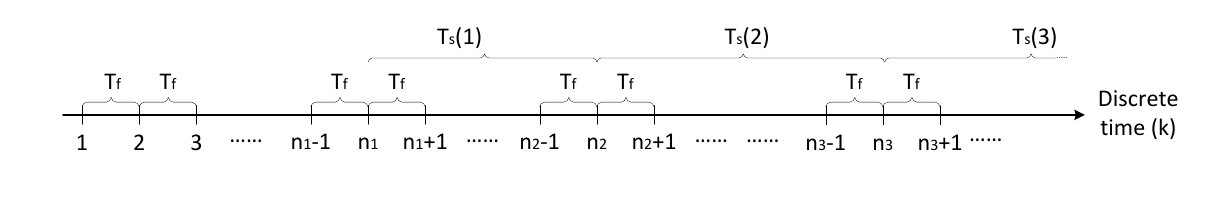
Figure 5: Time line showing the fast sampling rate T f used for the input variables, and the slow sampling rate T s ( i ) used for the output measurement (the aluminium height). As indicated T s ( i ) will vary with time, due to manual intervention, but it is adjusted to fit a variable multiple of T f . i indicates the i-th element of the output measurements sequence, while the inputs are sampled at each k